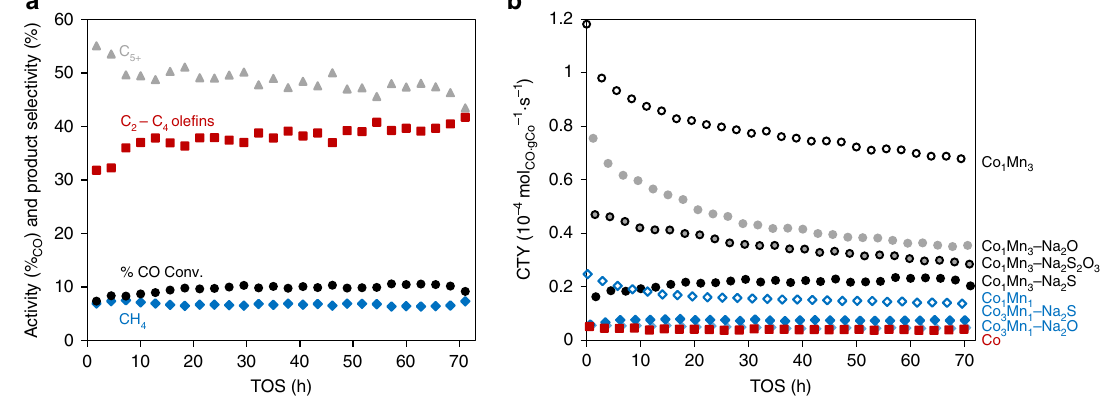
Fig. 2 Catalytic performance over 70 h time-on-stream. Reaction conditions: 240 °C, 3 bar, and H 2 /CO = 2. a Activity in terms of %CO conversion (black solid circles) and selectivity towards methane, CH 4 (blue solids diamonds), C 2 – C 4 ole fi ns (red solid squares), and C 5 + (grey solid triangles) of Co 1 Mn 3 – Na 2 S over time, and b activity in terms of cobalt-time-yield, CTY, of various Co-based catalysts, namely Co 1 Mn 3 (black open circles),